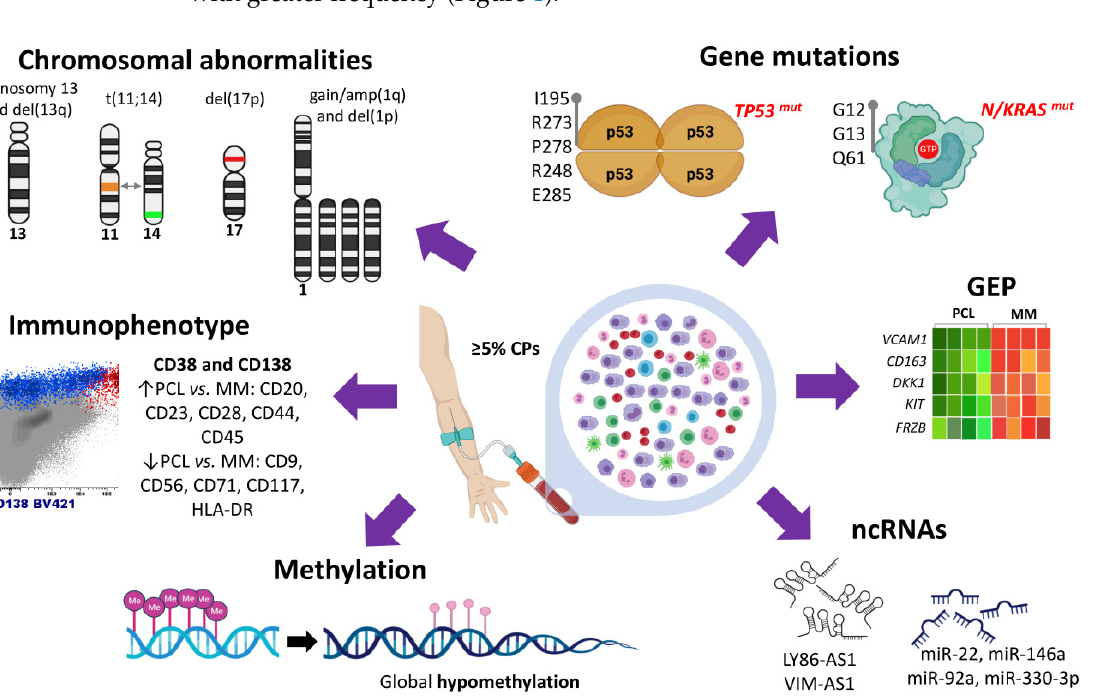
the impact of abnormalities in chromosome 1, both gain/amp(1q) and del(1p), on the survival of patients with MM is well established [45,46], their effect on the prognosis of pPCL is still poorly substantiated. Only one study has reported that del(1p), but not gain/amp(1q), is associated with shorter survival of PCL patients, although the set of sPCL included in the study may be biasing the influence that this chromosomal alteration might have on pPCL considered as a separate entity [22]. Deletion of 17p (del(17p)), although uncommon in MM at the time of diagnosis, reaches frequencies of 50% in pPCL [8,22,27,32,37]. However, it seems to have no impact on the prognosis of pPCL, unlike in MM [8,22].